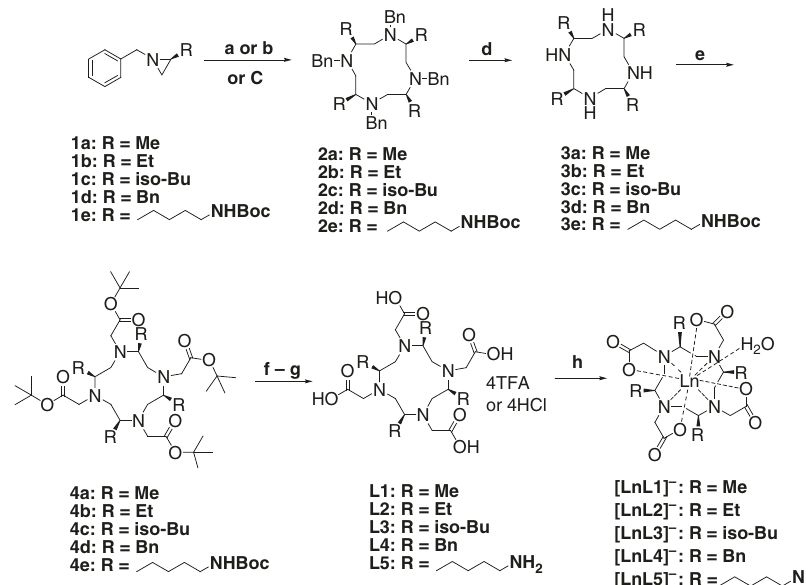
Fig. 1 Synthetic procedures of chiral DOTA complexes. The chiral cyclens were synthesised from chiral aziridines followed by the incorporation of protected acetate arms and subsequent deprotections to give the fi nal ligands. ( a ) TsOH/EtOH, RT ( 1a ); ( b ) BF 3 ·Et 2 O/Benzene, re fl ux ( 1b – 1d ), 24 h; ( c ) TsOH/ACN, RT ( 1b , 1e ); ( d ) Pd(OH) 2 /C, ammonium formate, tri fl uoroethanol, 50 – 75 °C, 16 h; ( e ) tert-butyl 2-bromoacetate, K 2 CO 3 , dry acetonitrile, 50 – 60 °C, 16 h; ( f ) TFA/DCM (1:1), 16 h; ( g ) 1 M HCl ( L2 – L4 ); ( h ) LnCl 3 ·6H 2 O, pH 7.0, 80 °C, 12 h (Ln = Eu(III), Yb(III) and Gd(III)), note for clarity